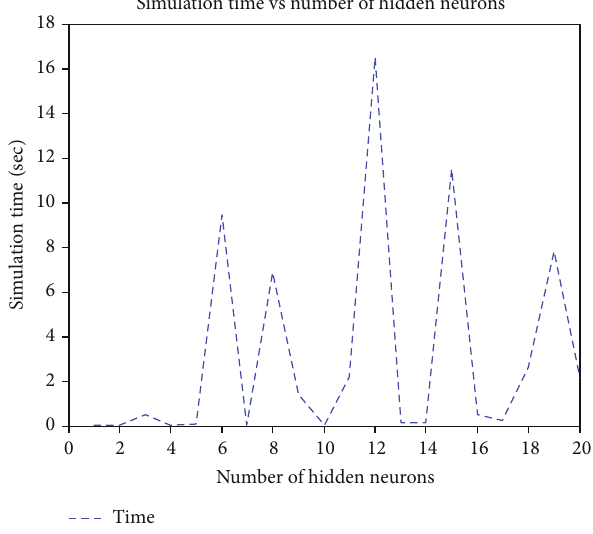
Figure 22: CMMLPNN-based forecasting model simulation time vs. the number of hidden